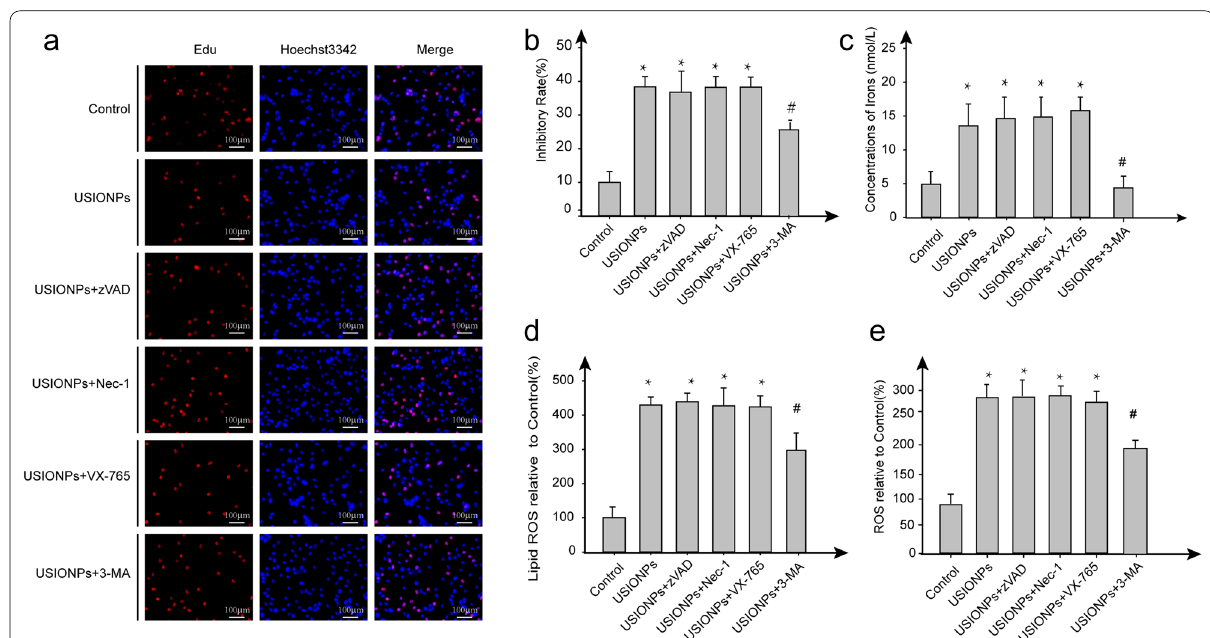
Fig.5 Effect on the USIONPs-induced ferroptosis after treatment with 200 μg/mL USIONPs, 20 μmol/L zVAD.fmk (apoptosis inhibitor), 20 μmol/L necrostatin-1 (necrosis inhibitor), 10 μmol/L VX765(pyroptosis inhibitor), and 10 μmol/L 3-MA (autophagy inhibitors) for 48 h. a Representative images of U251 cell proliferation by cell staining using Edu and Hoechst3342 (Magnification, 200 Concentrations of iron in the U251 cells; d Relative levels of lipid ROS in the U251 cells; (E)Relative levels of ROS in the U251 cells. * P < 0.05, statistically significant compared with control